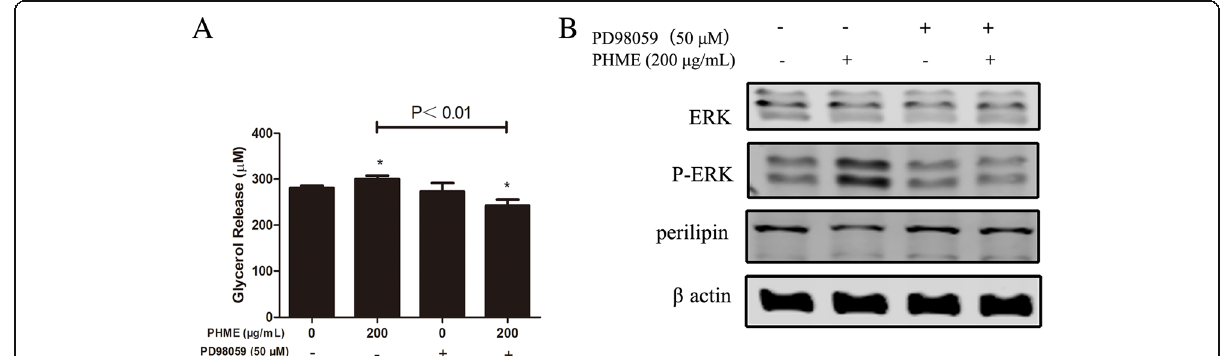
Fig. 5 Effects of an ERK inhibitor (PD98059) on PHME-stimulated lipolysis. a Fully differentiated 3T3-L1 adipocytes were treated with 200 μ g/mL PHME alone or in the presence of 50 μ M PD98059 for 12h, then contents of glycerol released into the medium were quantified. b Fully differentiated 3T3-L1 adipocytes were treated with 200 μ g/mL PHME alone or in the presence of 50 μ M PD98059 for 20h, then cells were lysed, and then ERK phosphorylation and expression of perilipin were measured using western blotting analysis. Values are expressed as mean±SD ( n =4), * P <0.05 vs. control